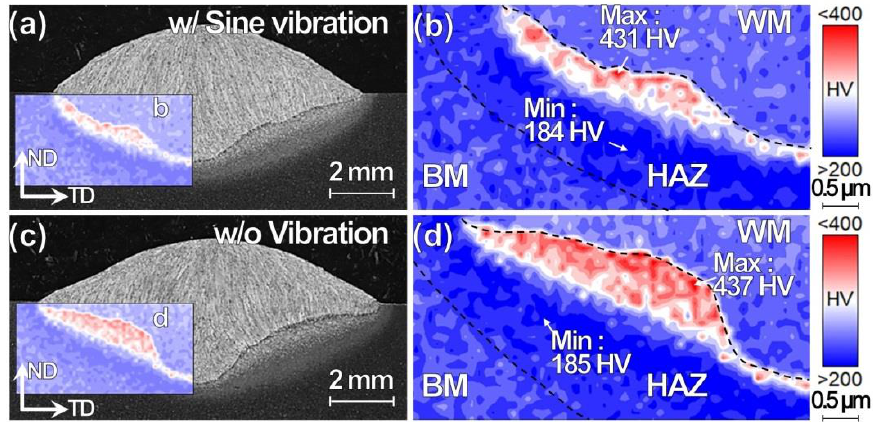
Figure 6. Cross-sectional ( a , c ) OM images and ( b , d ) hardness mappings for TP-GMAW specimens at 1.2 m / min ( a , b ) w / and ( c , d ) w / o sine vibration (F = 250 Hz, G = 1.2 m / s 2 and T = 30 s).